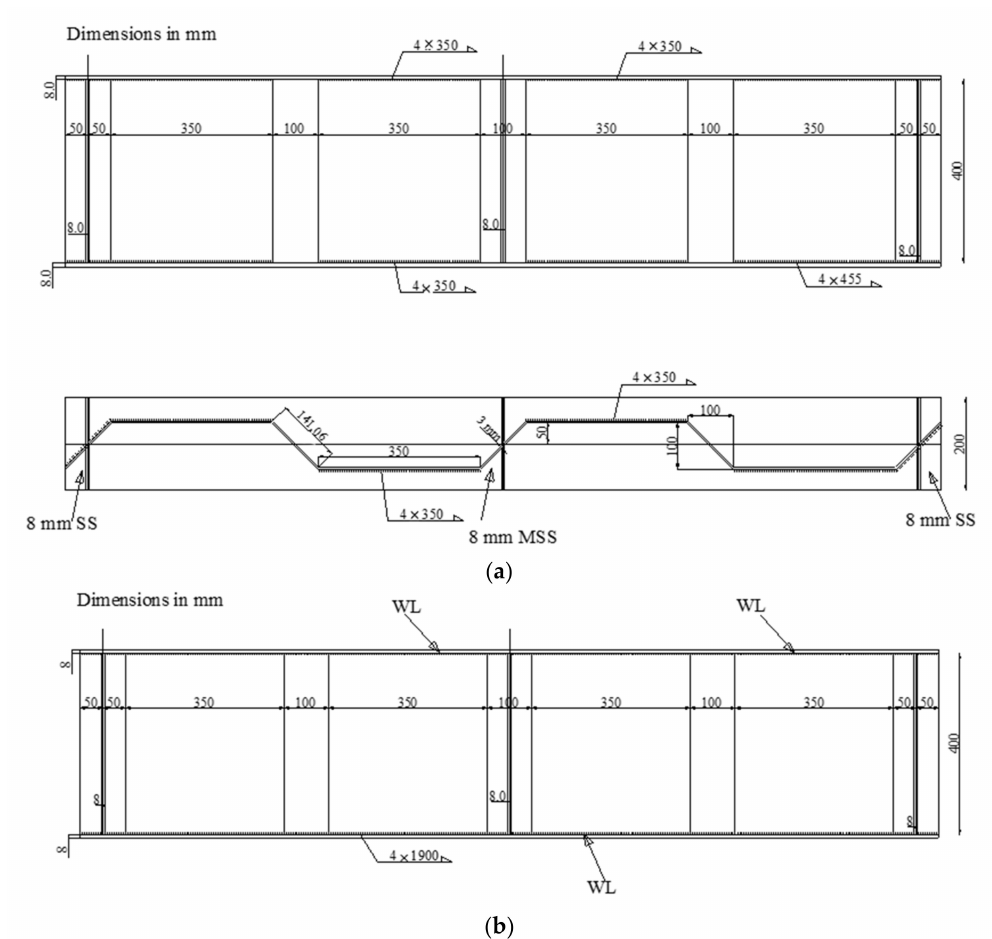
Figure 3. Details of the tested beams with a HF length of 350 mm: ( a ) CW35IFNW; ( b ) CW35IFWL.